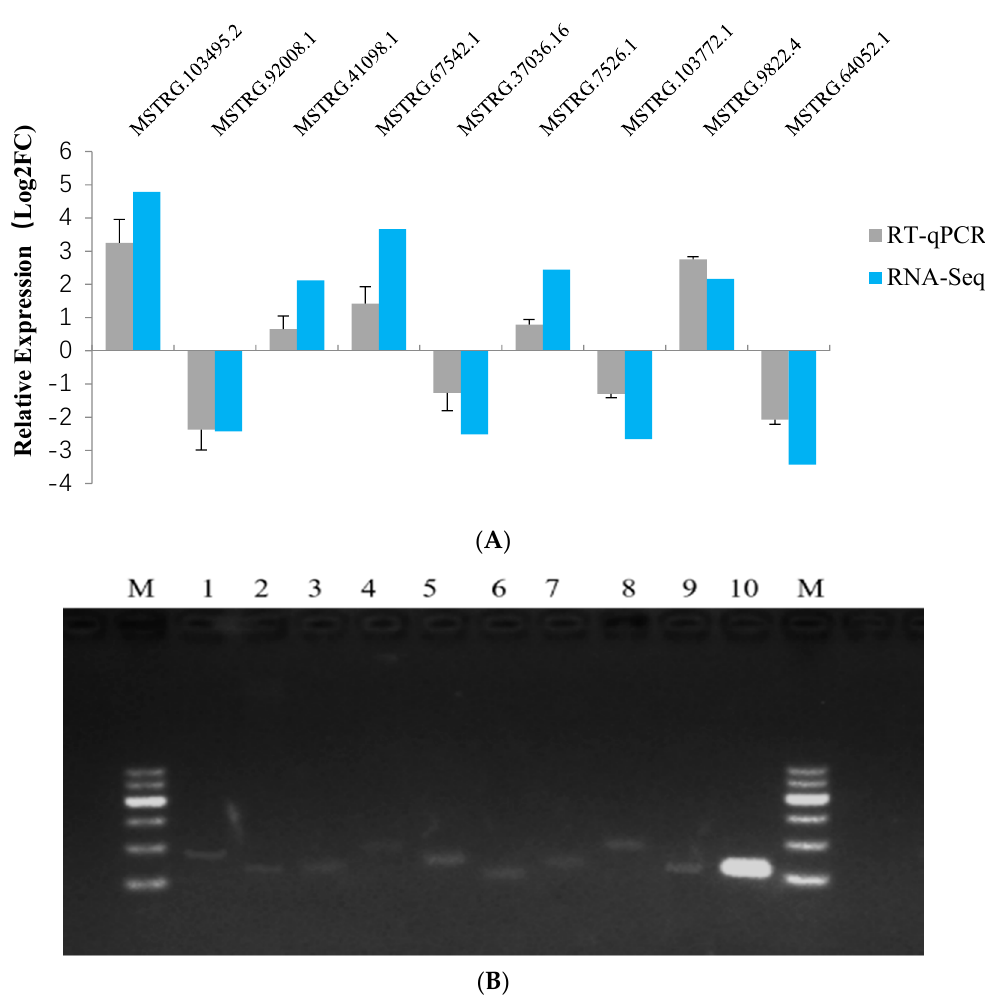
Figure 2. ( A ) RT-qPCR validation of nine differentially expressed lncRNAs identified using RNA-Seq. These result data showed the mean ±SD for three independent biological replicates and error bars indicated standard deviation. ( B ) RT-PCR amplification of lncRNAs using specific primers. 1: MSTRG.103495.2; 2: MSTRG.92008.1; 3: MSTRG.41098.1; 4: MSTRG.67542.1; 5: MSTRG.37036.16; 6: